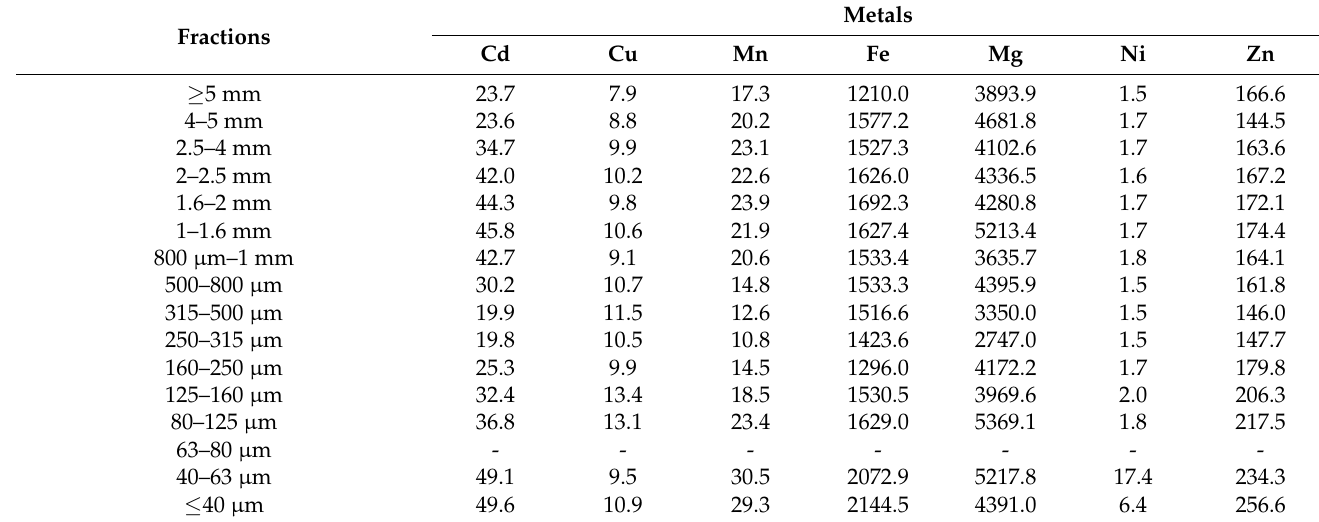
Table 2. Metals concentrations ( µ g g − 1 ) in different fractions of phosphate ore from Djebel Onk.